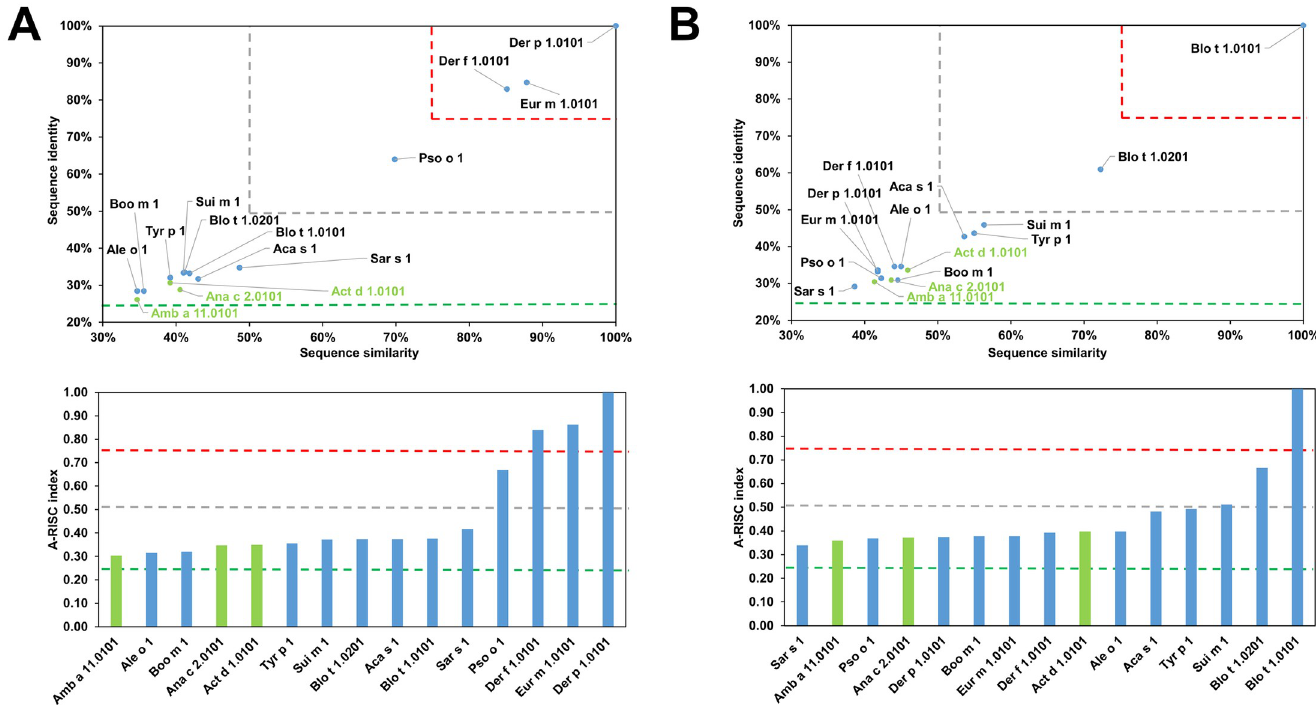
Fig 2. Plots showing relative homology and A-RISC indexes of allergens from the papain-like cysteine protease family. Comparison of other family members to Der p 1.0101 (A) and Blo t 1.0101 (B). Allergens originating from plants are shown in green. Red, gray and dark green dashed lines indicate 75%, 50% and 25% sequence identity and similarity respectively, or 0.75, 0.50 and 0.25 A-RISC values.